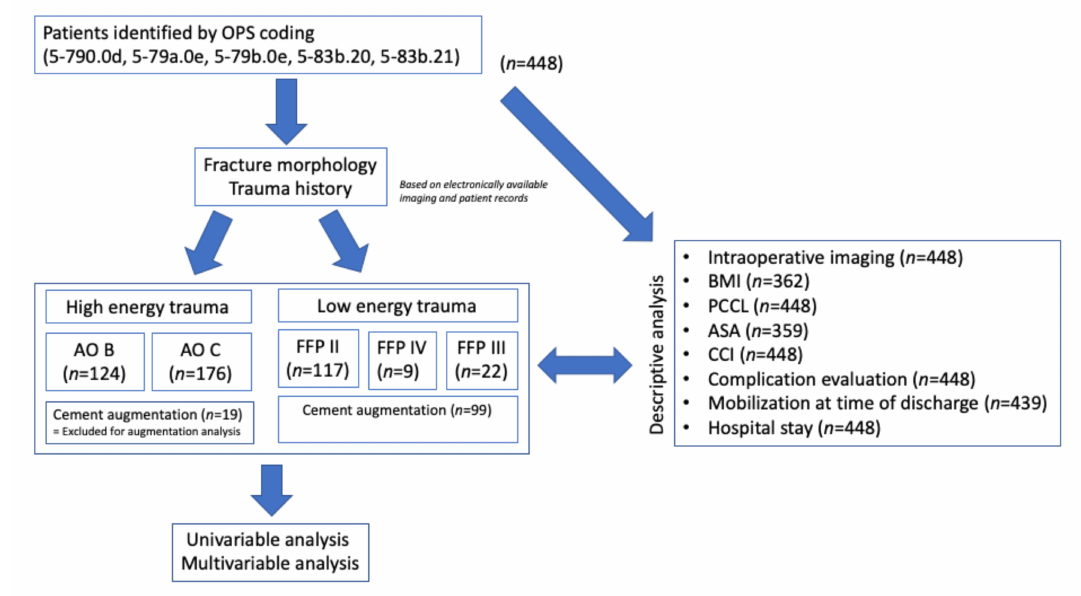
Figure 1. Schematic overview of the included cases according to the STrengthening the Reporting of OBservational studies in Epidemiology (STROBE) recommendations [32]. High-energy trauma was excluded from the analysis of augmentation. No follow-up was performed. Reduced numbers represent missing data in available sources. In all cases, a clinical report and a distinct radiological report or imaging was available. In cases of available electronic imaging, classification was performed by the authors. Patients without a history of high-energy trauma were re-classified using the fragility fractures of the pelvis (FFP) classification (FFP II—non-displaced posterior ring fracture; FFP III—displaced unilateral posterior pelvic ring fracture; and FFP IV—displaced bilateral posterior pelvic ring fracture). OPS = operation and procedure coding; AO = Arbeitsgemeinschaft für Osteosynthesefragen; FFP = Fragility fractures of the pelvis; BMI = Body mass index; PCCL = Patient Clinical Complexity Level; ASA = American Society of Anesthesiologists score; CCI = Charlson Comorbidity Index. Sex distribution in both AO groups ( n = 300) was f / m 39.67% / 60.33% and in all FFP groups ( n = 148) f / m 87.84%;12.16%, respectively. The di ff erent distribution of age separated by sex is presented